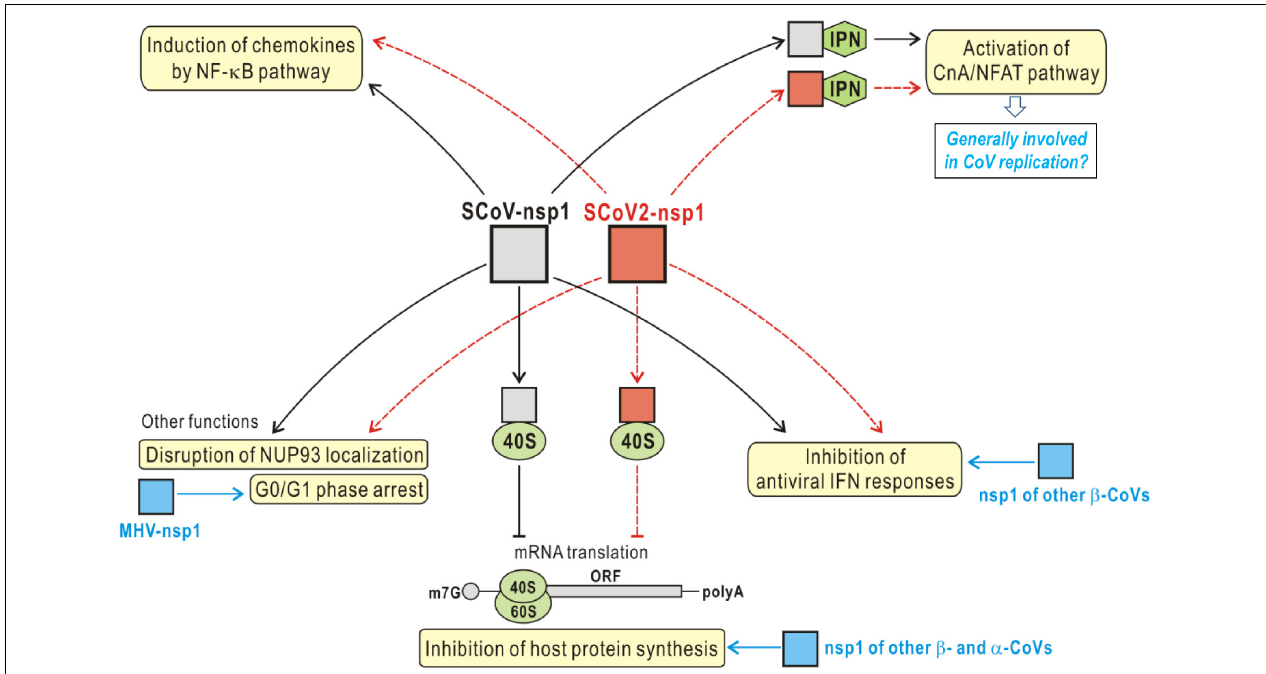
FIGURE 5 | Potential functions of nsp1. The reported functions of SARS-CoV nsp1 (SCoV-nsp1) include inhibition of host protein synthesis by binding to 40S ribosomal subunit, inhibition of antiviral IFN responses, activation of CnA/NFAT signaling by interacting with immunophilins (IPN), induction of chemokines, disruption of NUP93 localization, and induction of cell cycle arrest in G0/G1 phase (summarized in the yellow textboxes). Notably, some of these functions are shared by the nsp1 of other representative CoVs (indicated in blue), despite the low sequence identifies of the nsp1 proteins. In addition, the cellular CnA/NFAT pathway also seems to be generally involved in CoV replication, as inhibition of the pathway could block the replication of not only SARS-CoV ( β -CoV), but also the CoVs from other genera. Given the high sequence identity and the possible structural similarity, SARS-CoV-2 nsp1 (SCoV2-nsp1) likely has the activities similar to those of SCoV-nsp1, which merit systematic investigations in the future for better understanding of the viral infection and pathogenesis and development of drugs or vaccines. See also the descriptions in the